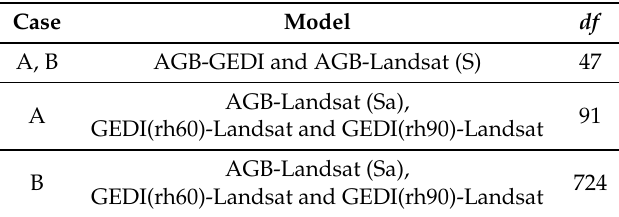
Table 6. Degree of freedom ( df ) for the models